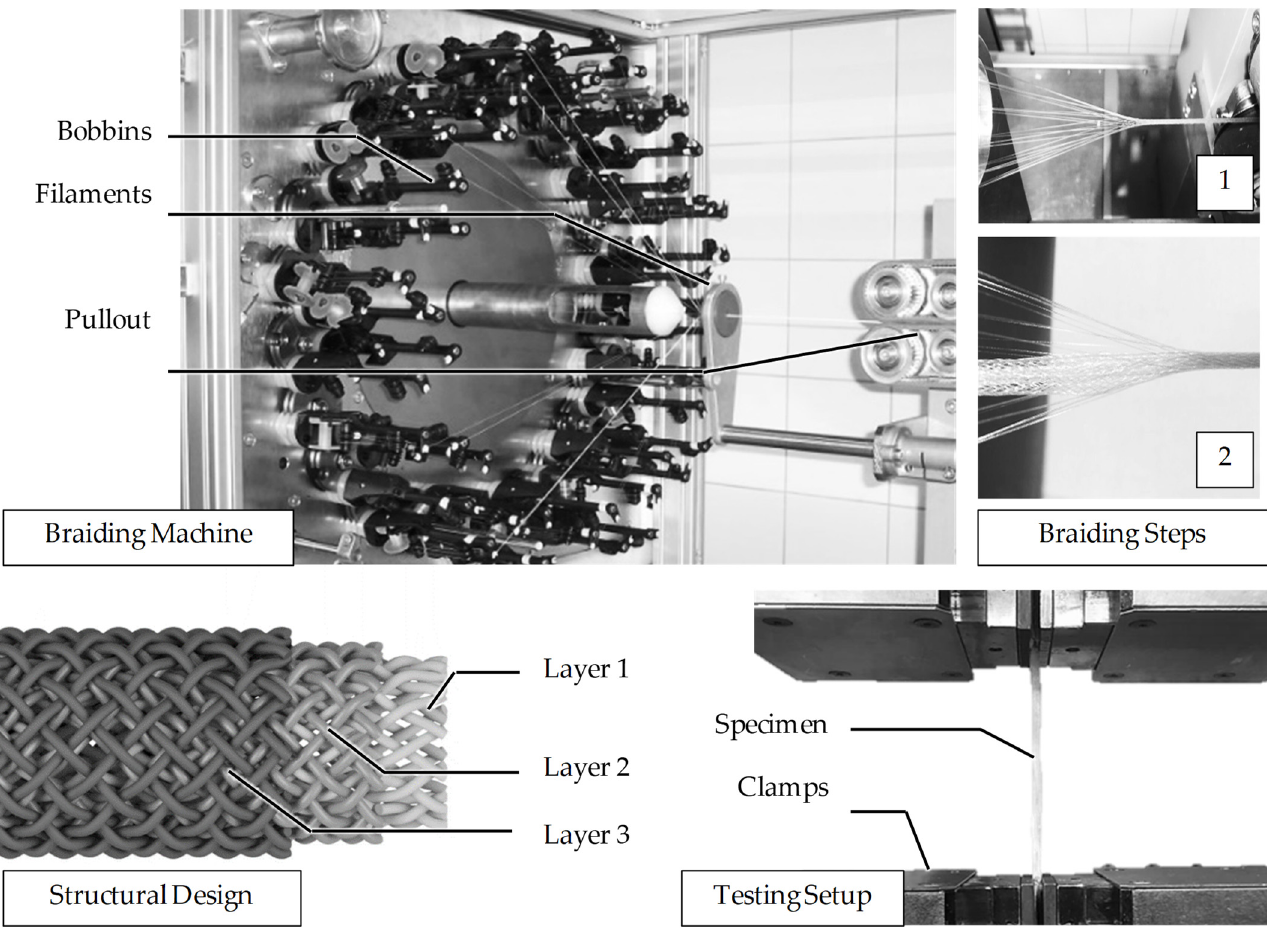
Figure 7. Multi-stage circular braiding process for scaffold production based on a three-layer design.